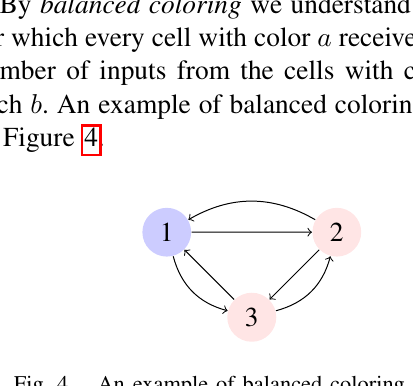
Fig. 5. An quotient network for the network from Figure 4 formed based on